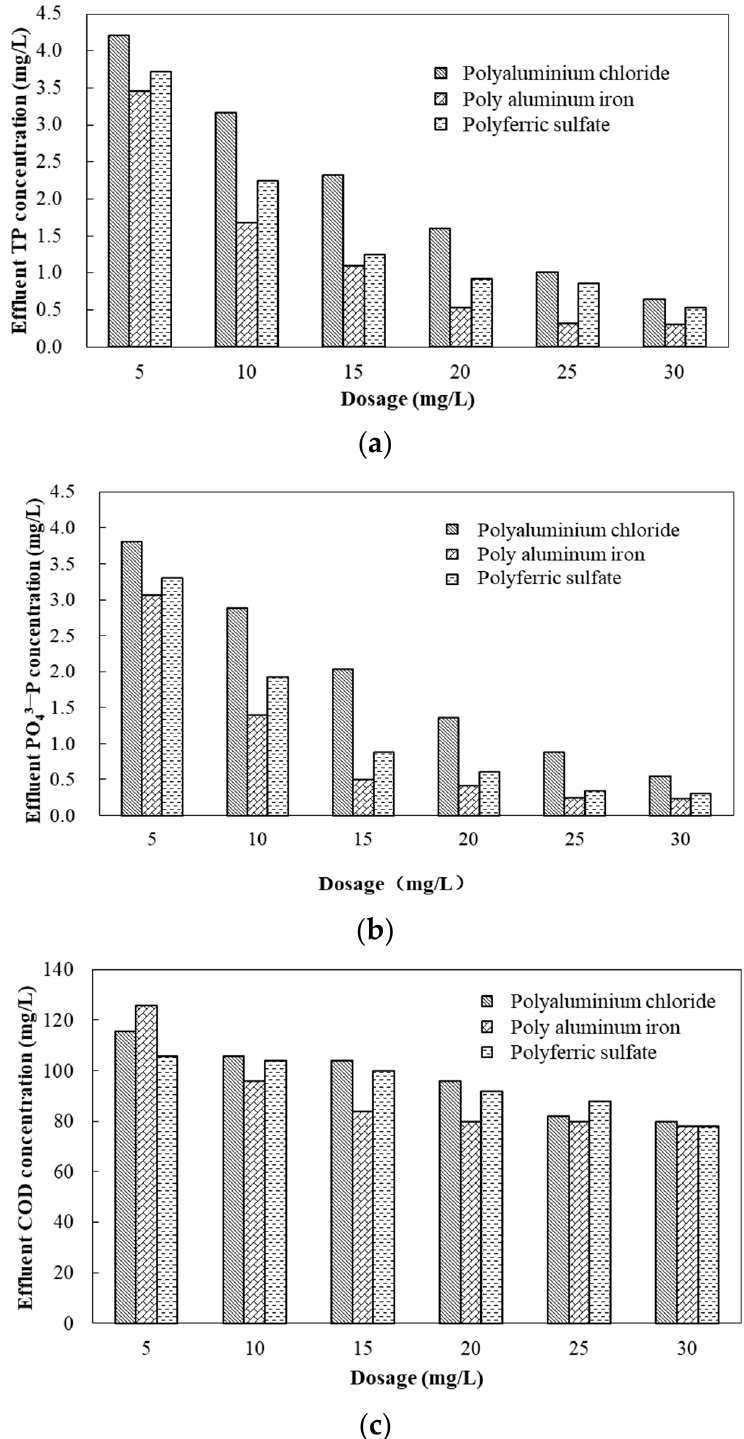
Figure 17. ( a ) The effect of phosphorus removal agents on TP in the influent tank; ( b ) The effect of phosphorus removal agents on PO 43 − –P in the influent tank; and ( c ) The effect of phosphorus removal agents on COD in the influent tank.